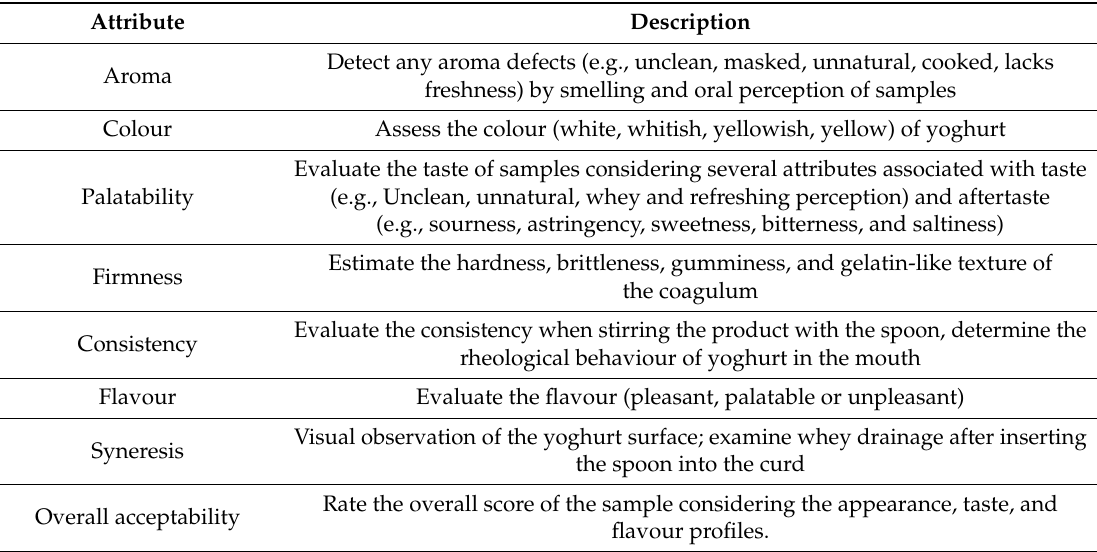
Table 1. Definition of the descriptors (sensory attributes) used for evaluation of the pigeon pea acetylated starch stabilized set-type